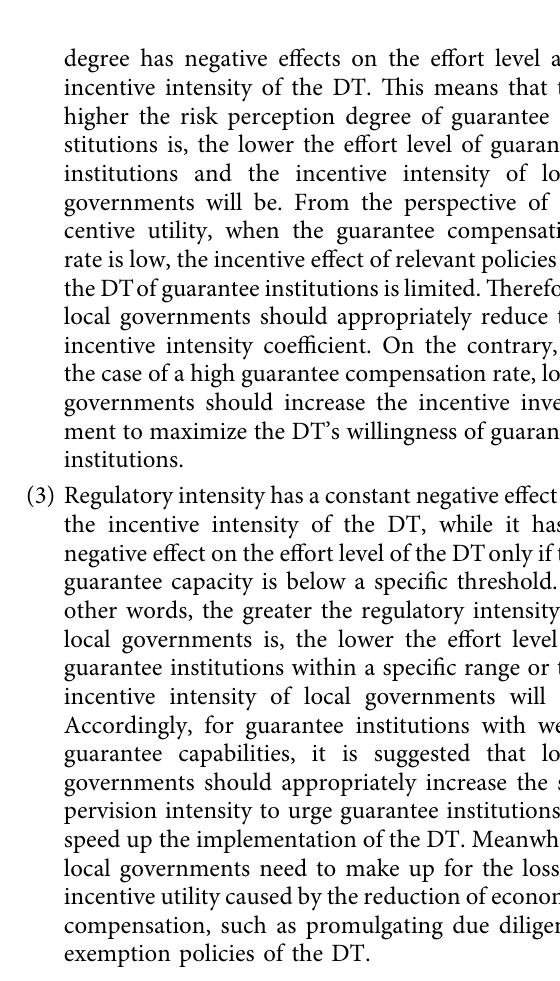
Figure 3: Effect results of risk perception degree and regulatory intensity on incentive intensity of DT. (a) The scenario result of array V. (b) The scenario result of array